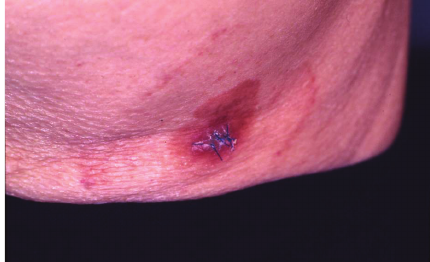
Figure 19: Clinical photograph showing a red, scaly plaque on the skin surface. The patient just had a biopsy performed with sutures still in place.